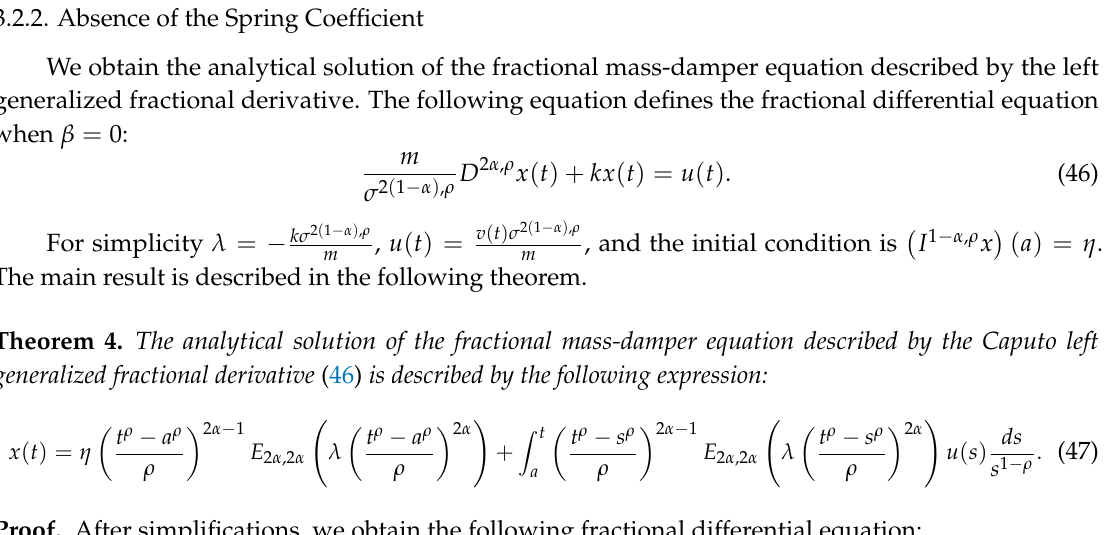
Figure 10. Numerical simulation for Equation (45) considering different values of α , arbitrarily